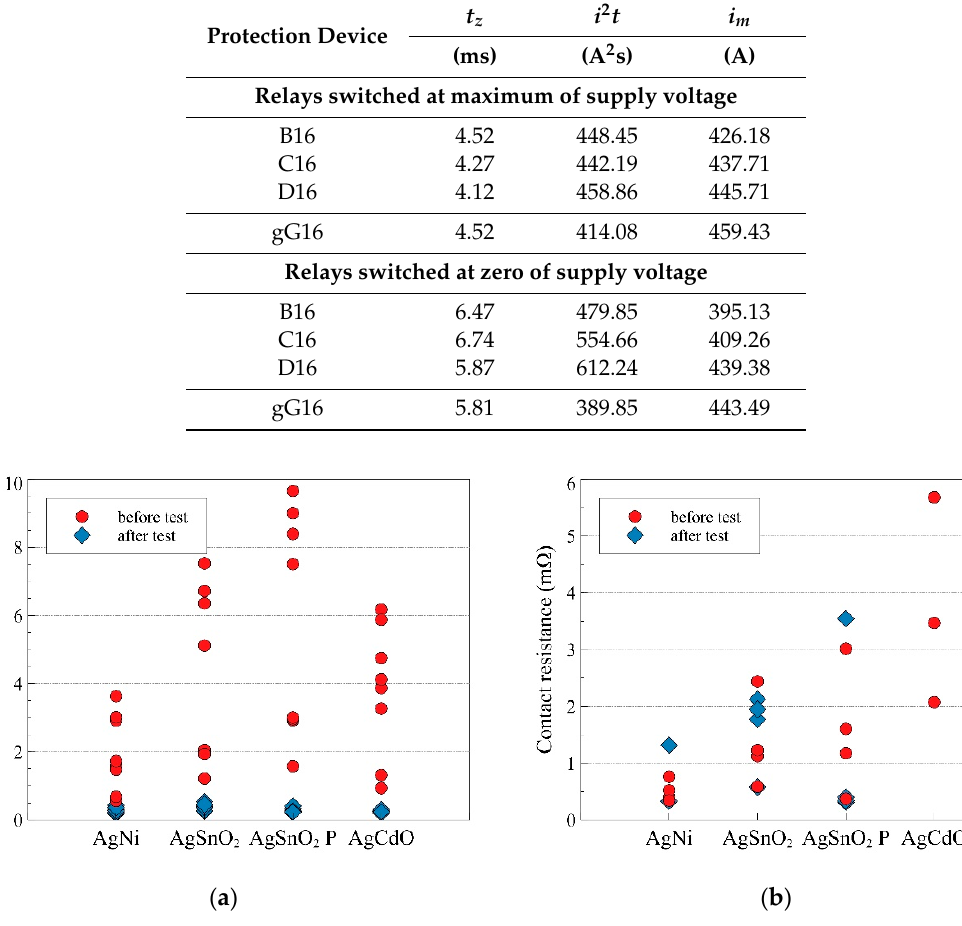
Table 3. Mean values of the time periods for short circuits t z , Joule’s integral i 2 t , and maximal short-circuit current i m at switching the short-circuit current.